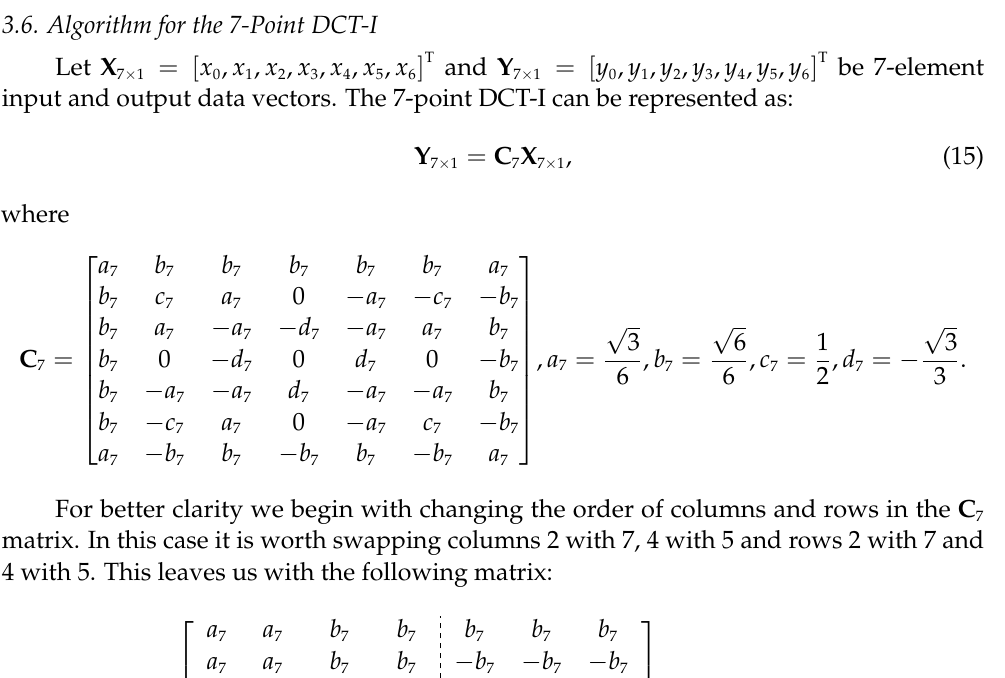
Figure 5. Signal flow graph of the algorithm for computing the 6-point